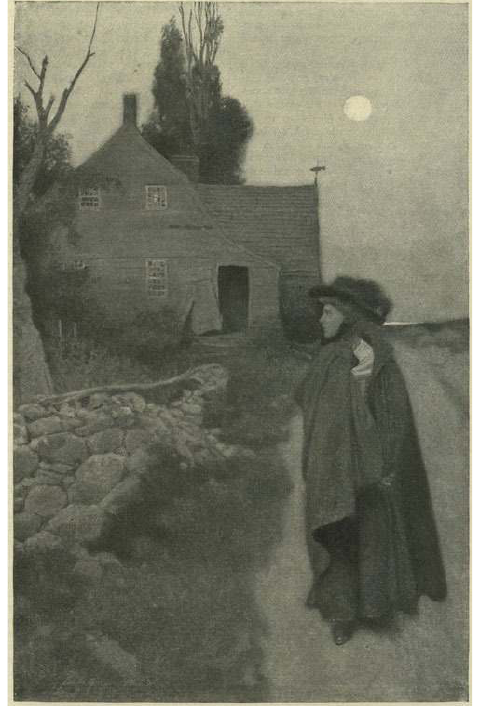
Illustrating Mary E. Wilkins Freeman’s story “The